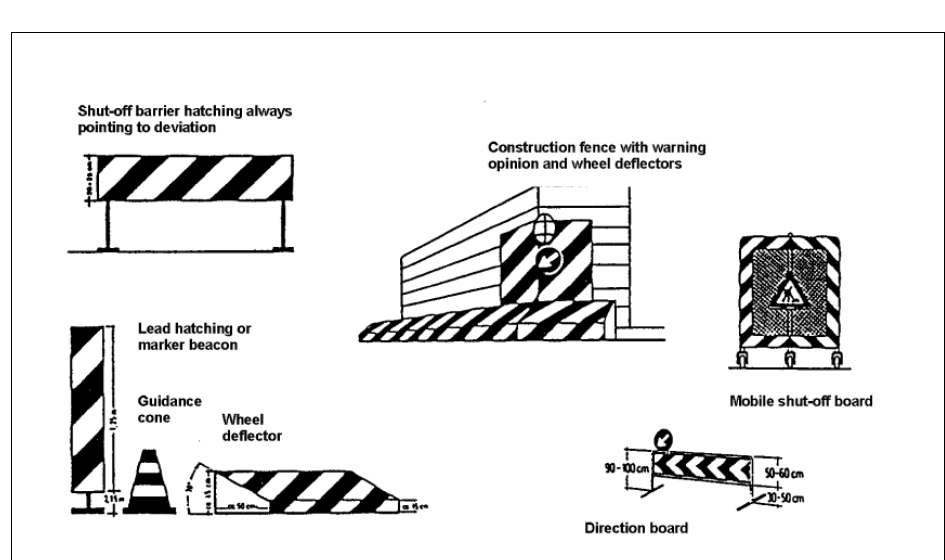
Fig 1. A covered pedestrian path on construction sites